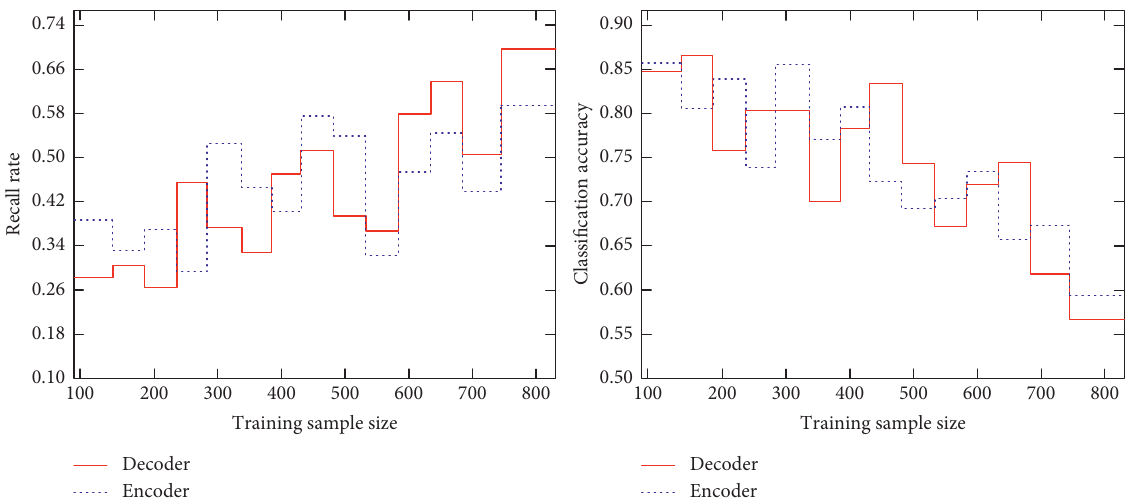
Figure 6: Recall rate and classification accuracy with different training sample size in decoder and encoder.